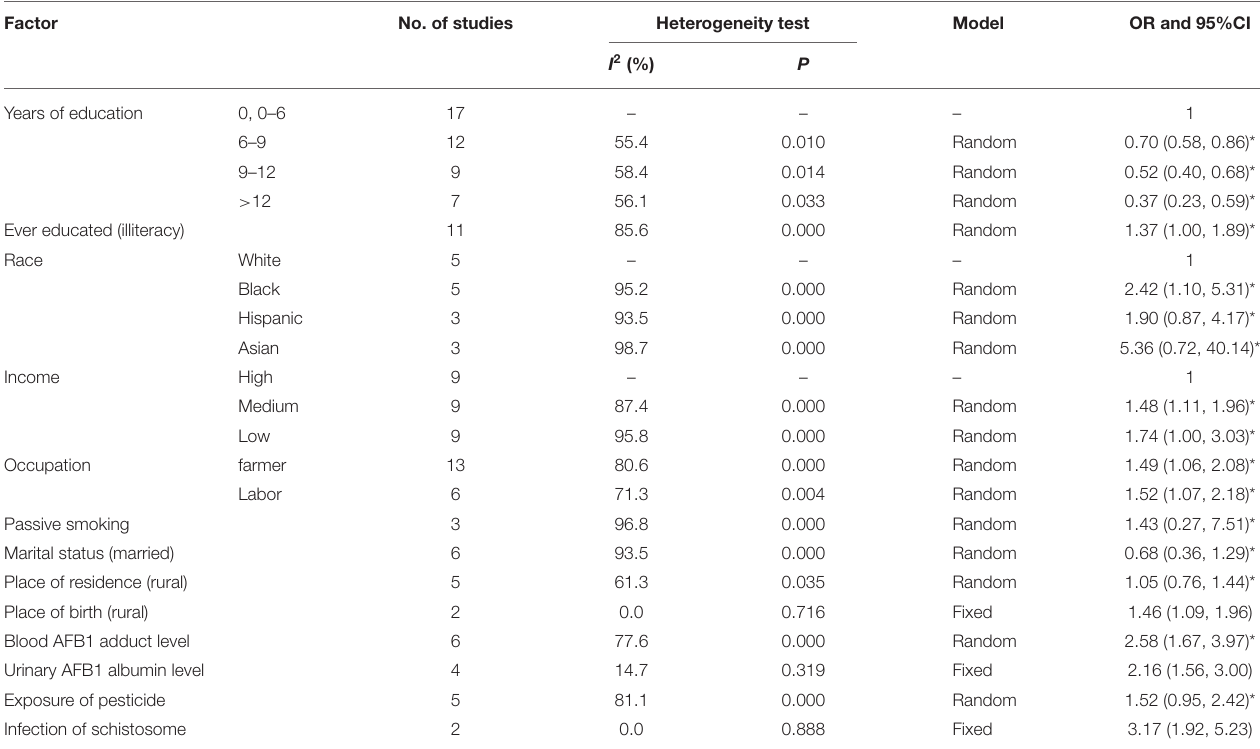
TABLE 1 | The result of heterogeneity